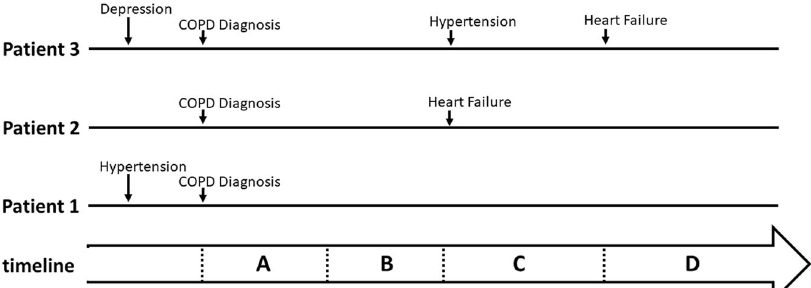
Fig. 1 Illustration to show how time-varying exposures are de fi ned. Timeline of three illustrative patients to show how time-varying exposures are de fi ned. Patient 1 is considered to have hypertension at the time of COPD diagnosis and is thus considered to have hypertension in periods A – D. Patient 2 only has COPD in periods A and B but has both COPD and Heart Failure in periods C and D. Patient 3 has COPD and depression in periods A – D, COPD, depression and hypertension in periods C and D, and COPD, depression, hypertension and heart failure in period